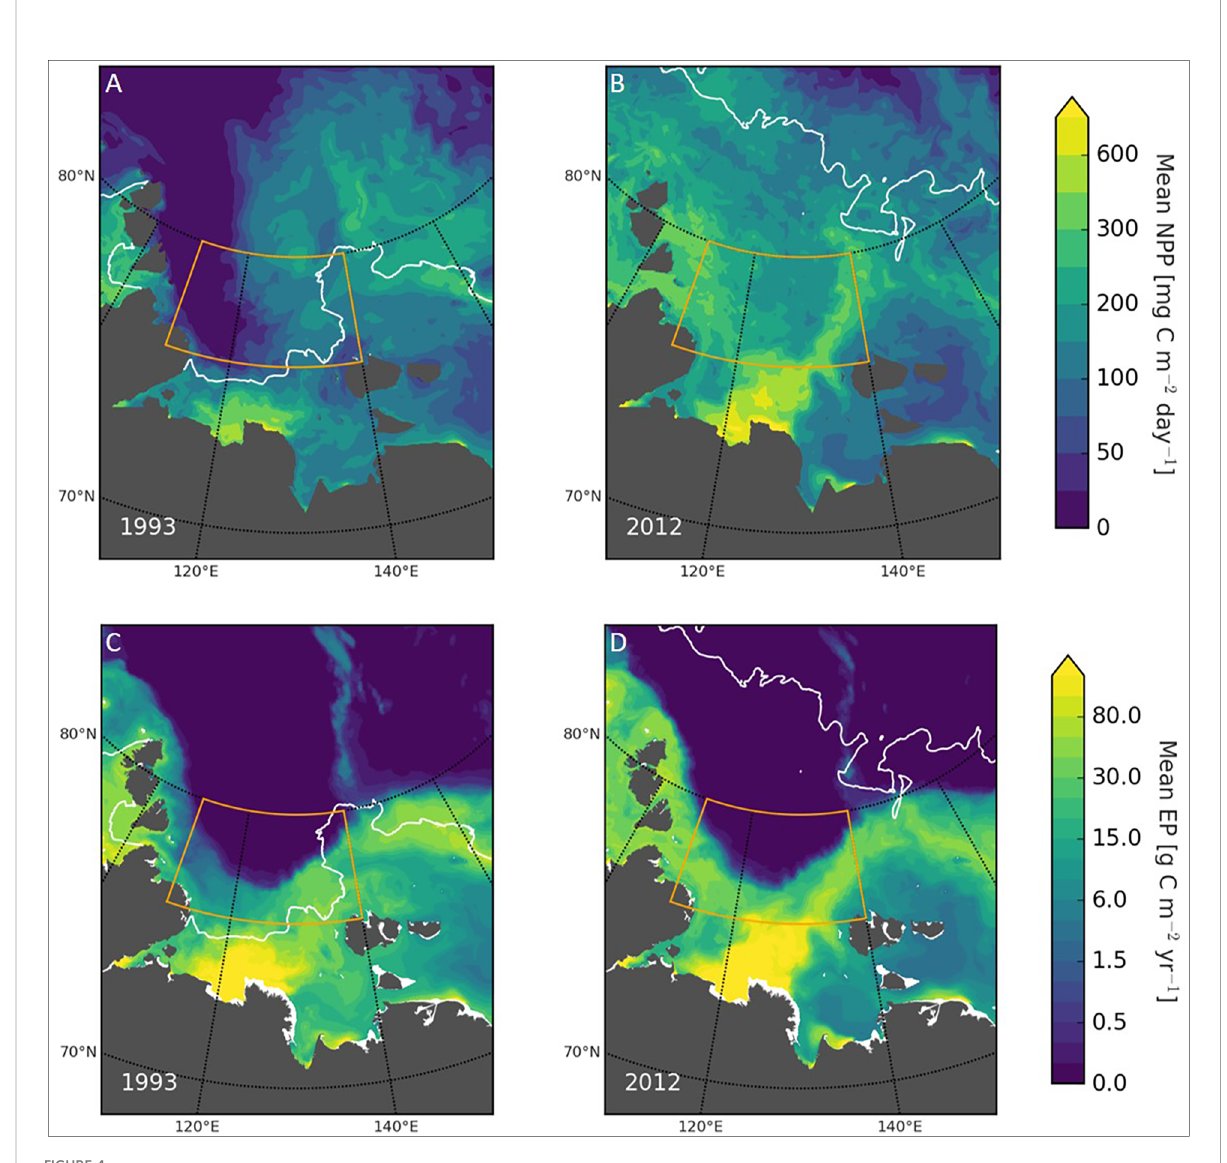
FIGURE 4 Modelled primary production and POC fl ux. Top: Modelled mean primary production averaged over July, August and September in 1993 (A) and 2012 (B) . Bottom: Modelled vertical POC fl ux to the sea fl oor in 1993 (C) and 2012 (D) . The orange rectangles indicate the area of interest. The white line indicates the ice margin. Regulated Ecosystem Model 2 (REcoM2) coupled to the Finite Element Sea Ice-Ocean Model (FESOM), with a resolution of 4.5